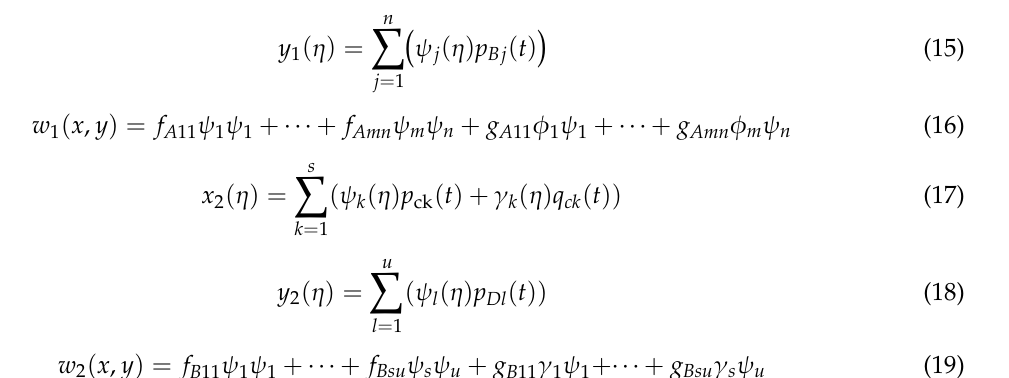
Figure 3. The arrangement of the tank in a ship: ( a ) the general shape of tank; ( b ) simplification of the ship tank shape.